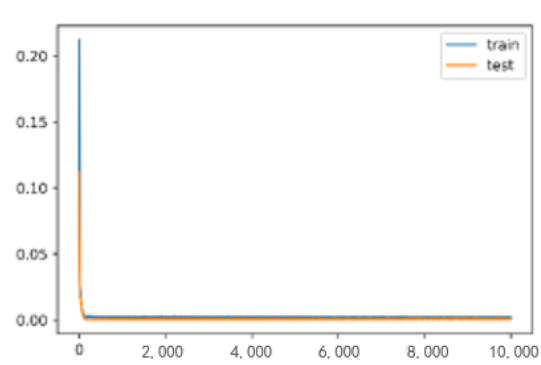
Figure 8. The auto-regressive training result of BP.